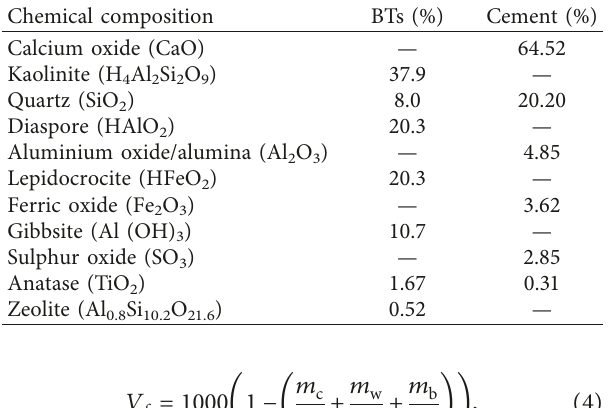
Table 3: Four levels of each affecting